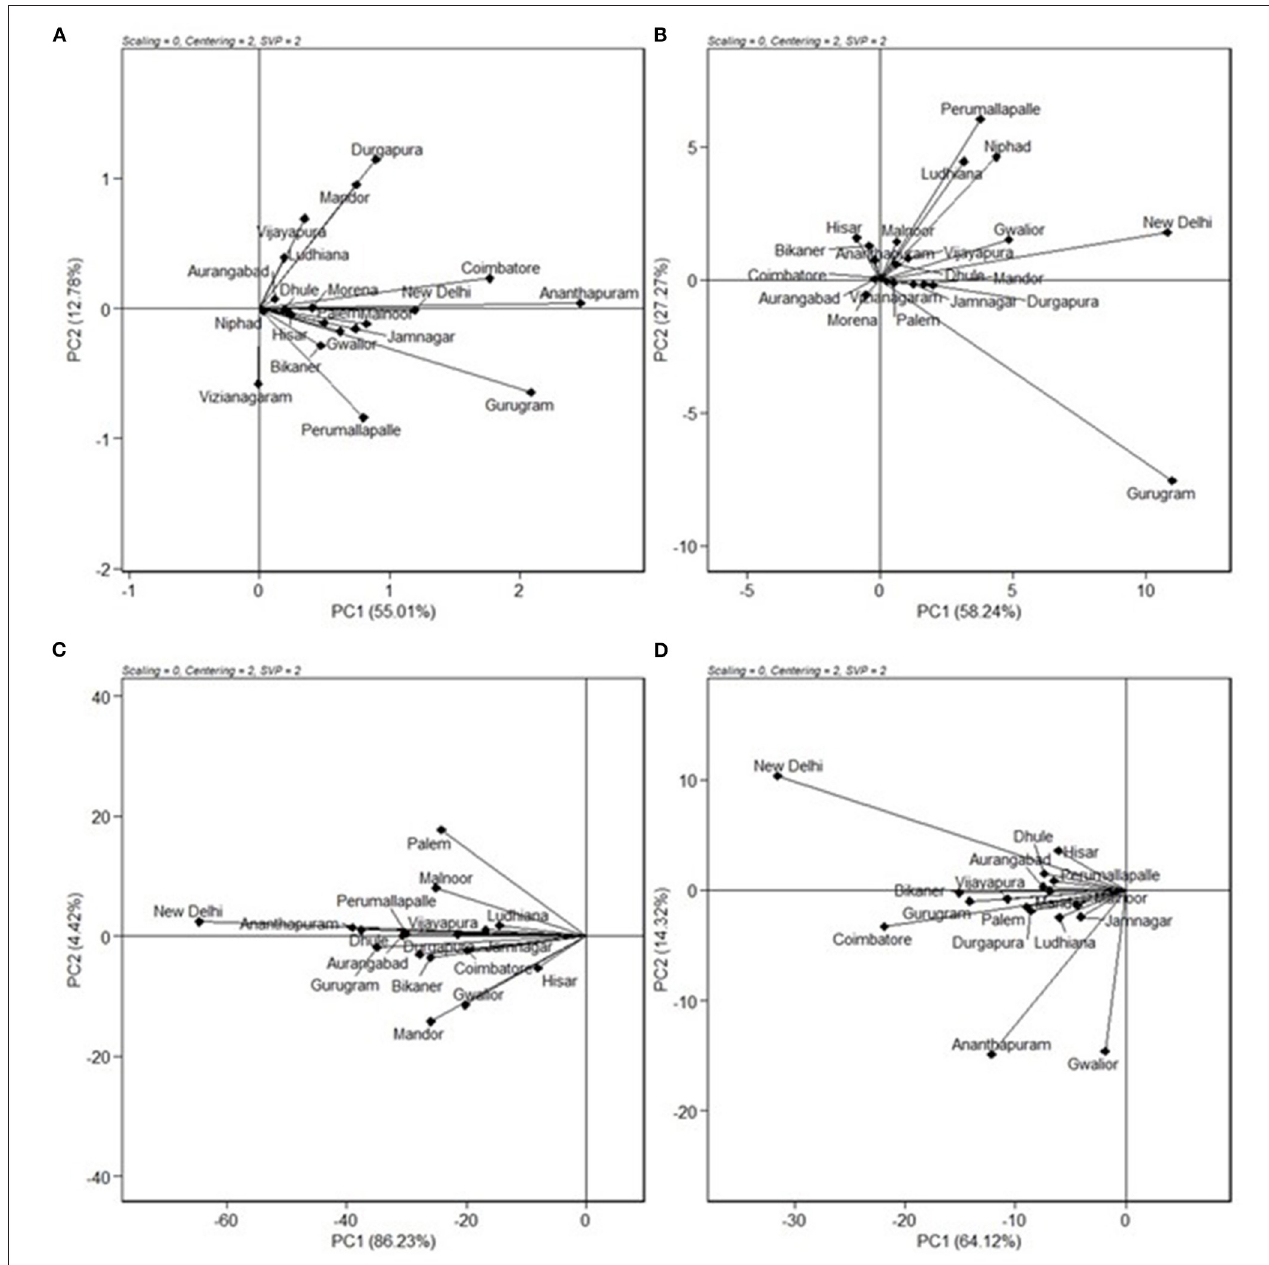
FIGURE 3 | GGE biplot showing “relationship among environments” of nine pearl millet OPVs across 20 locations for (A) grain yield, (B) dry fodder yield, (C) grain Fe content, and (D) grain Zn content.